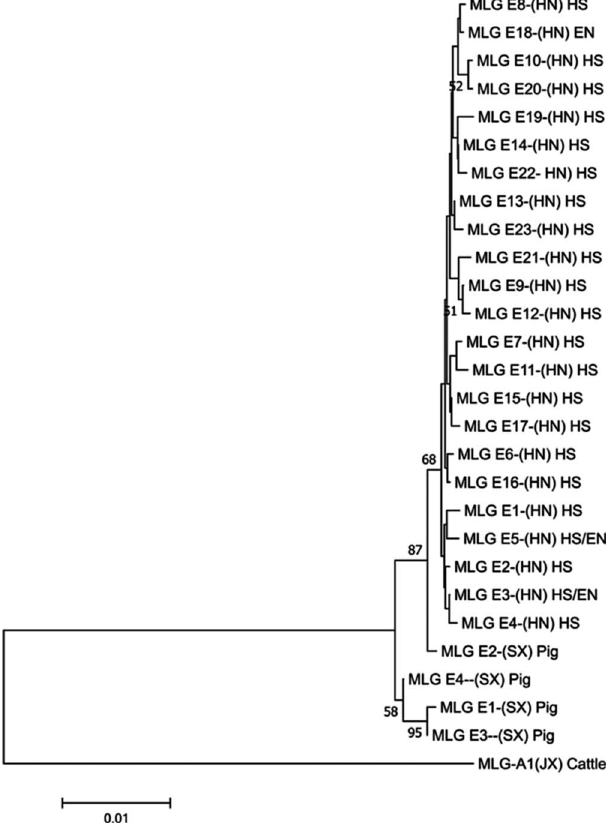
Figure 1. Phylogenetic relationships among G. duodenalis MLGs. The phylogenetic tree was constructed using a concatenated dataset of the bg , tpi, and gdh gene sequences and Neighbor-Joining analysis with the Tamura – Nei model. MLGs with unambiguous sequences identi fi ed in this study (Table 5) were analyzed with reference isolates. Bootstrap values greater than 50% from 1000 replicates are shown at the nodes. HN: Henan; SX: Shaanxi; JX: Jiangxi; HS: Hu sheep; EN: